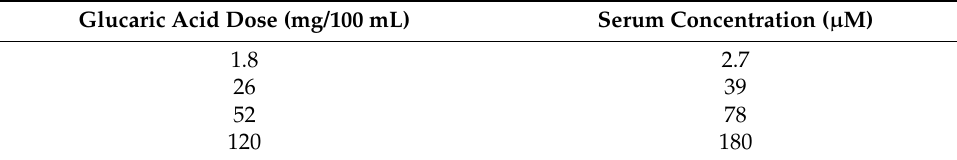
Table 1. Glucaric acid doses and their respective serum